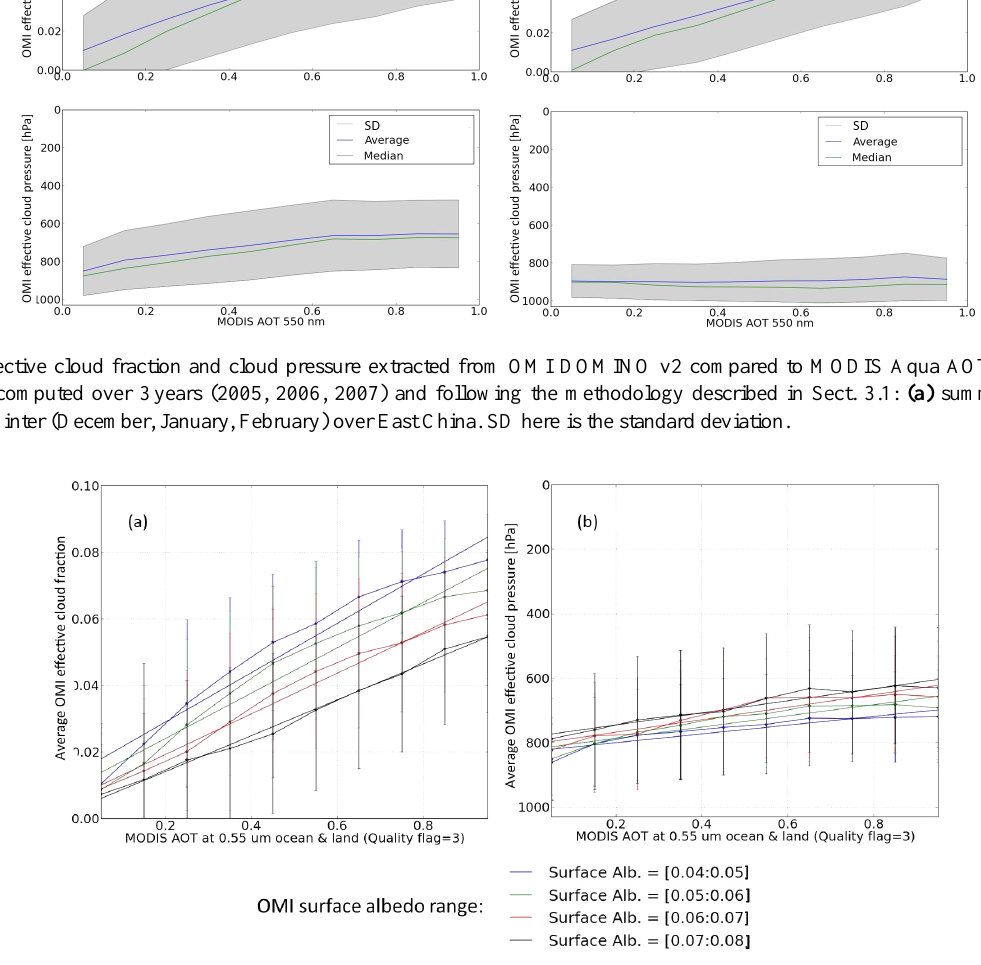
face properties that impact the average light path (e.g.